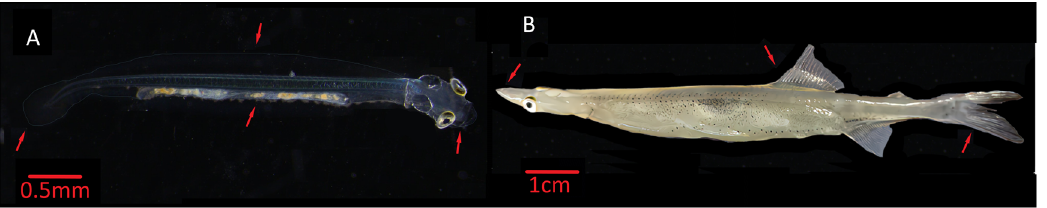
Figure 1. Morphological comparison pictures of the larva and adult clearhead icefish : ( A ) larval fish; ( B ) adult fish.